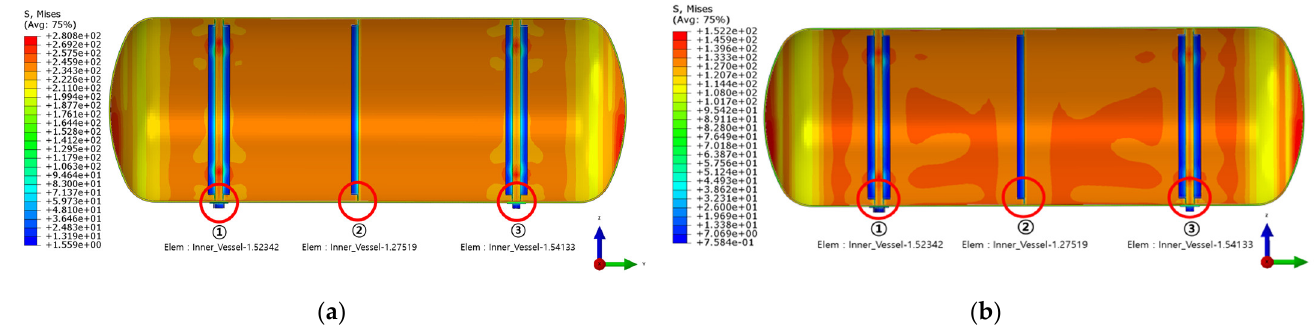
Figure 19. Stress contour in full-load condition for fatigue evaluation: ( a ) SUS304; ( b ) AL-5083-O.